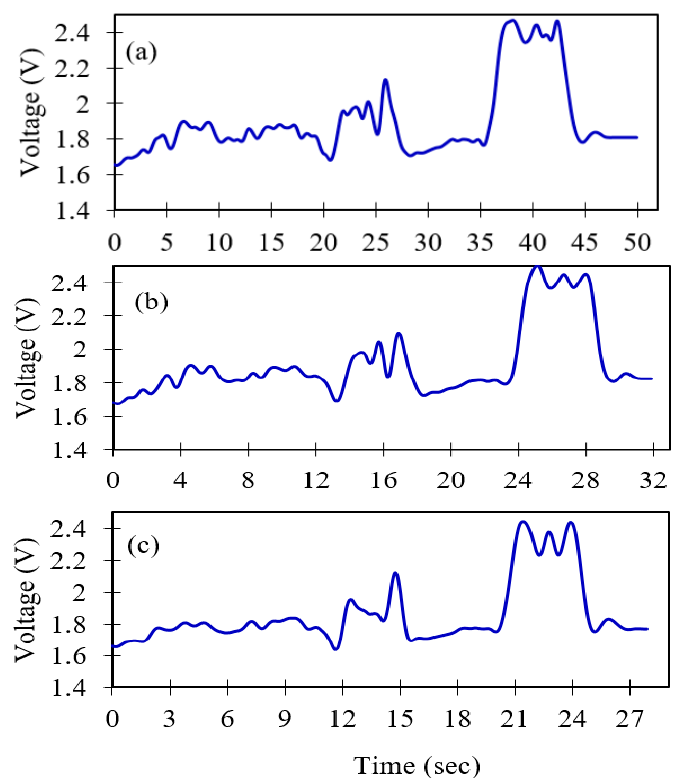
Figure 10. Discrete wavelet transform (DWT) de-noised sensor signals at different inspection speeds at the third decomposing level for 20-mm lift-off; ( a ) 7.3 mm/s, ( b ) 11 mm/s and, ( c ) 13 mm/s.